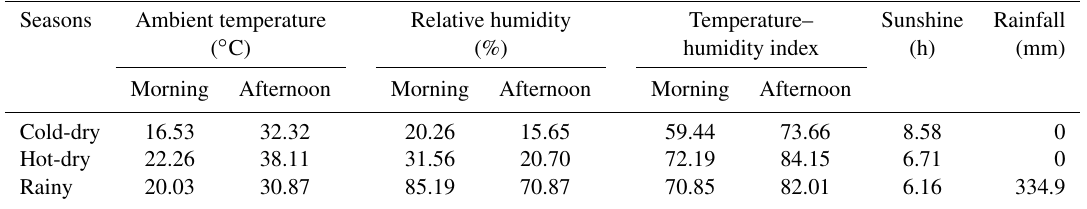
Table 1. Mean values of meteorological parameters during the study period. Seasons Ambient temperature